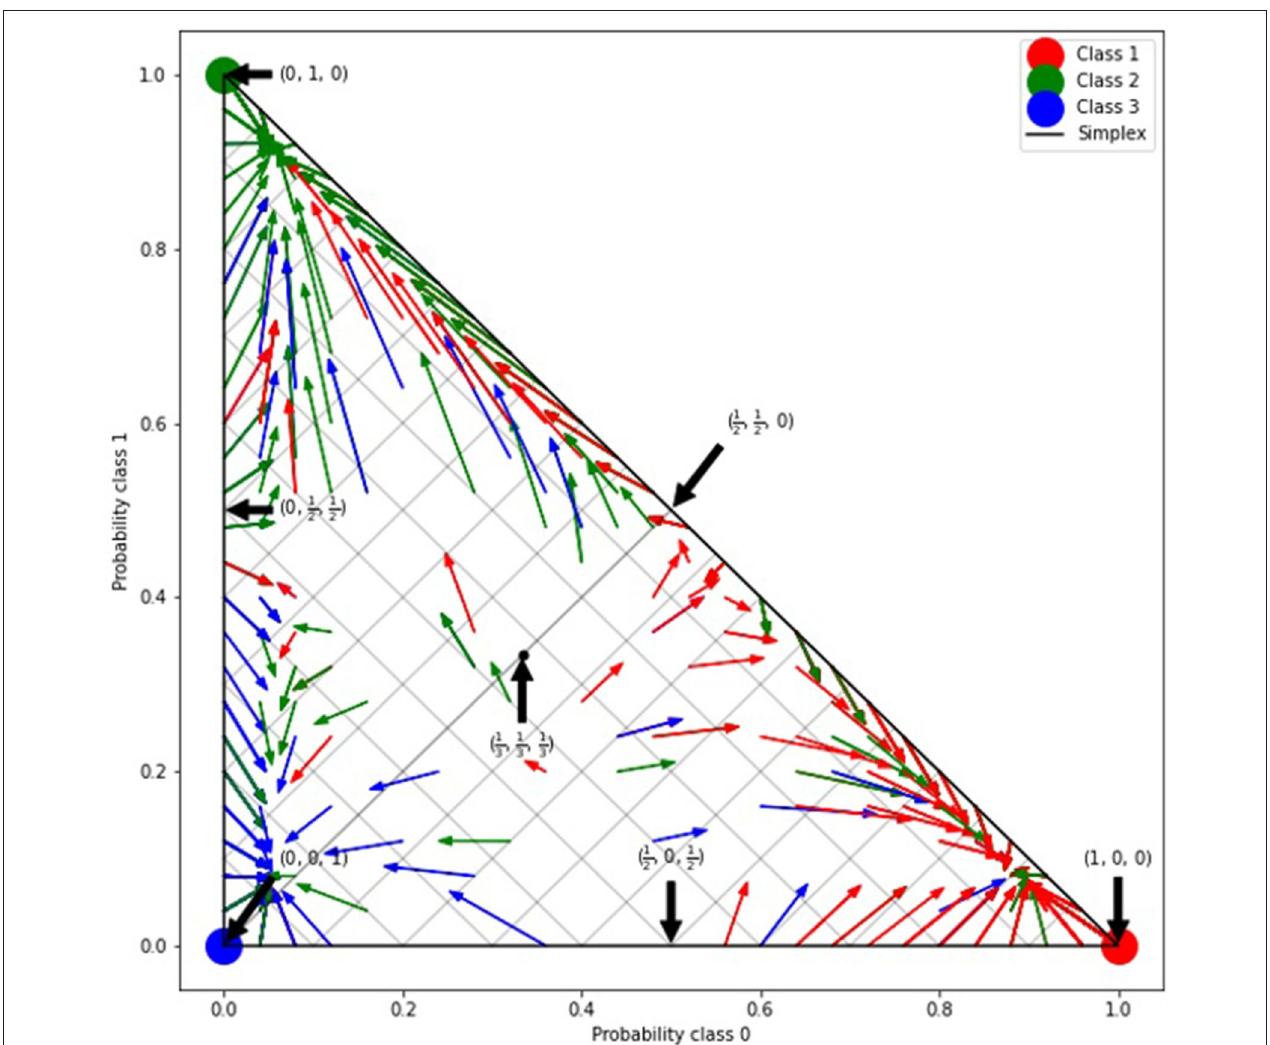
FIGURE 6 | Following calibration using isotonic and SIRD model, change in expected probability on test